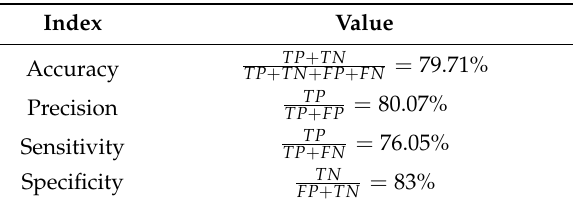
Table 10. Statistical indices of the results.